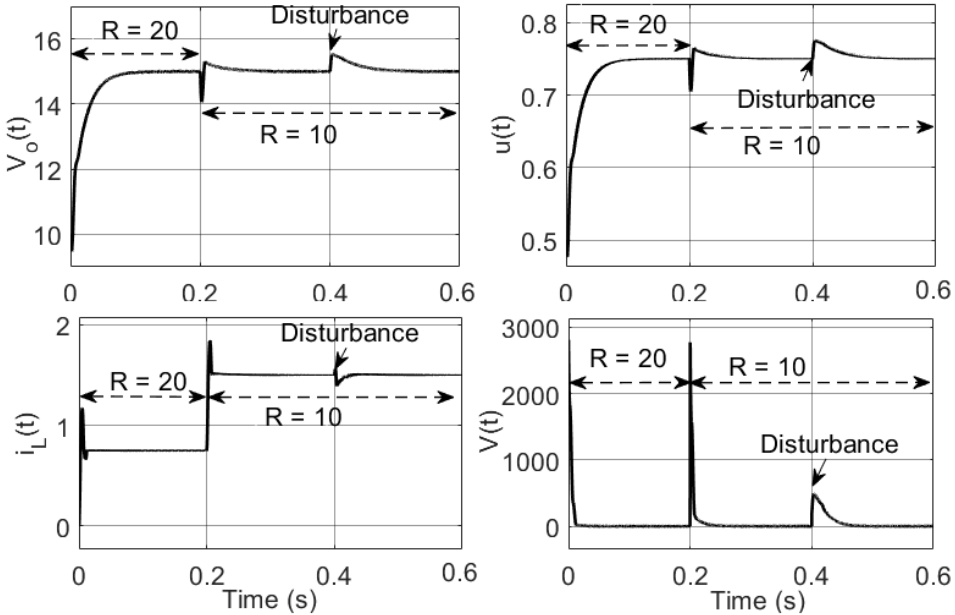
Figure 3. Time trajectories of the output voltage v o ( t ) , inductor current i L ( t ) , control signal u ( t ) , and the Lyapunov function (Load variation +